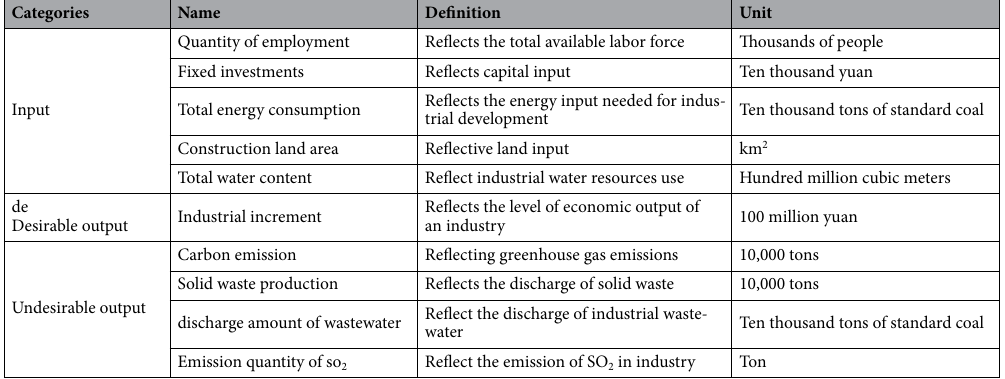
Table 1. Evaluation index system of regional ecologicalization efficiency of industry.